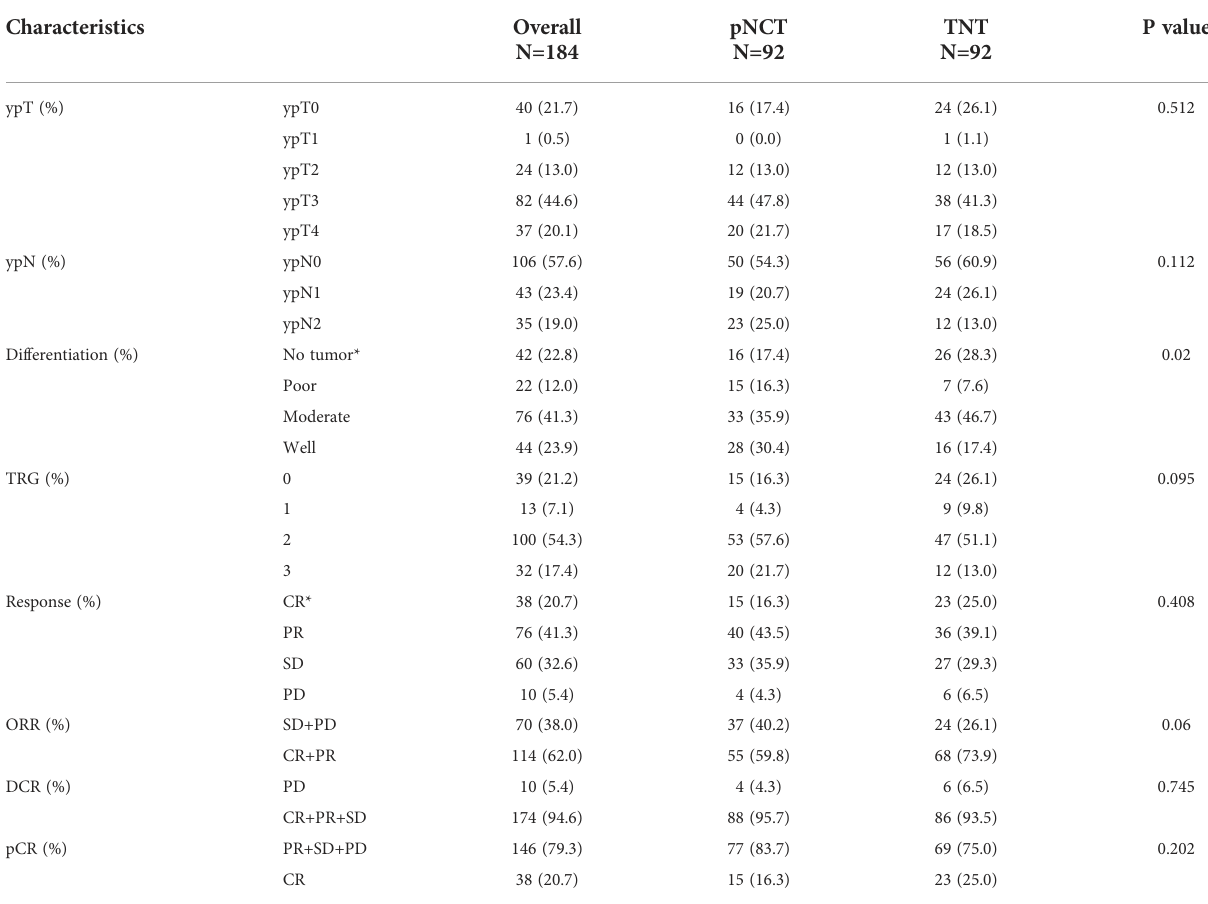
TABLE 2 Pathological result of tumor response to neoadjuvant therapy.